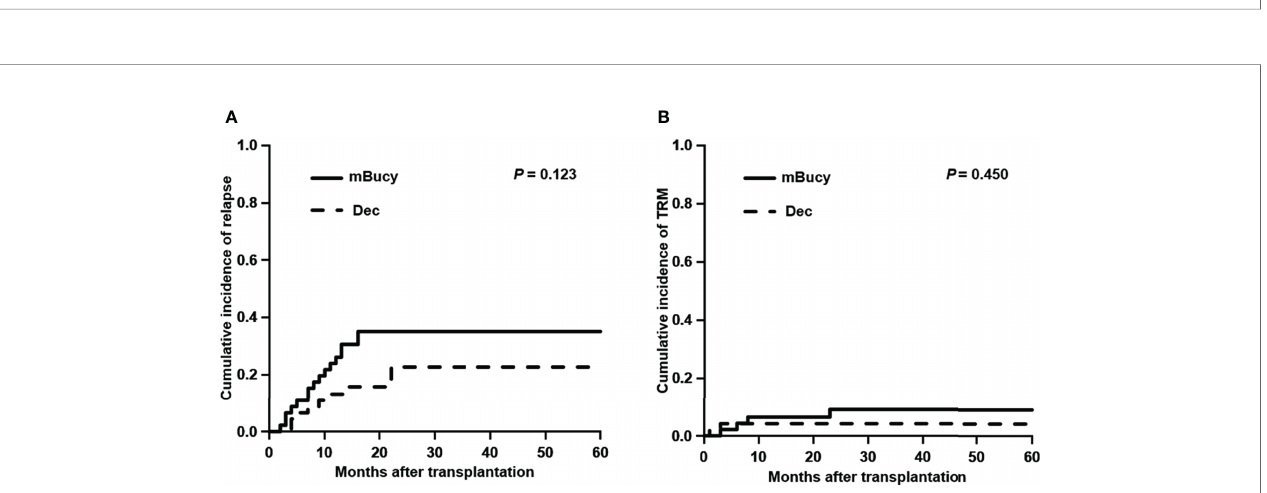
FIGURE 2 | Cumulative incidence of (A) relapse and (B) transplant-related mortality (TRM) in the decitabine (Dec) group and the modi fi ed busulfan/cyclophosphamide (mBuCy)